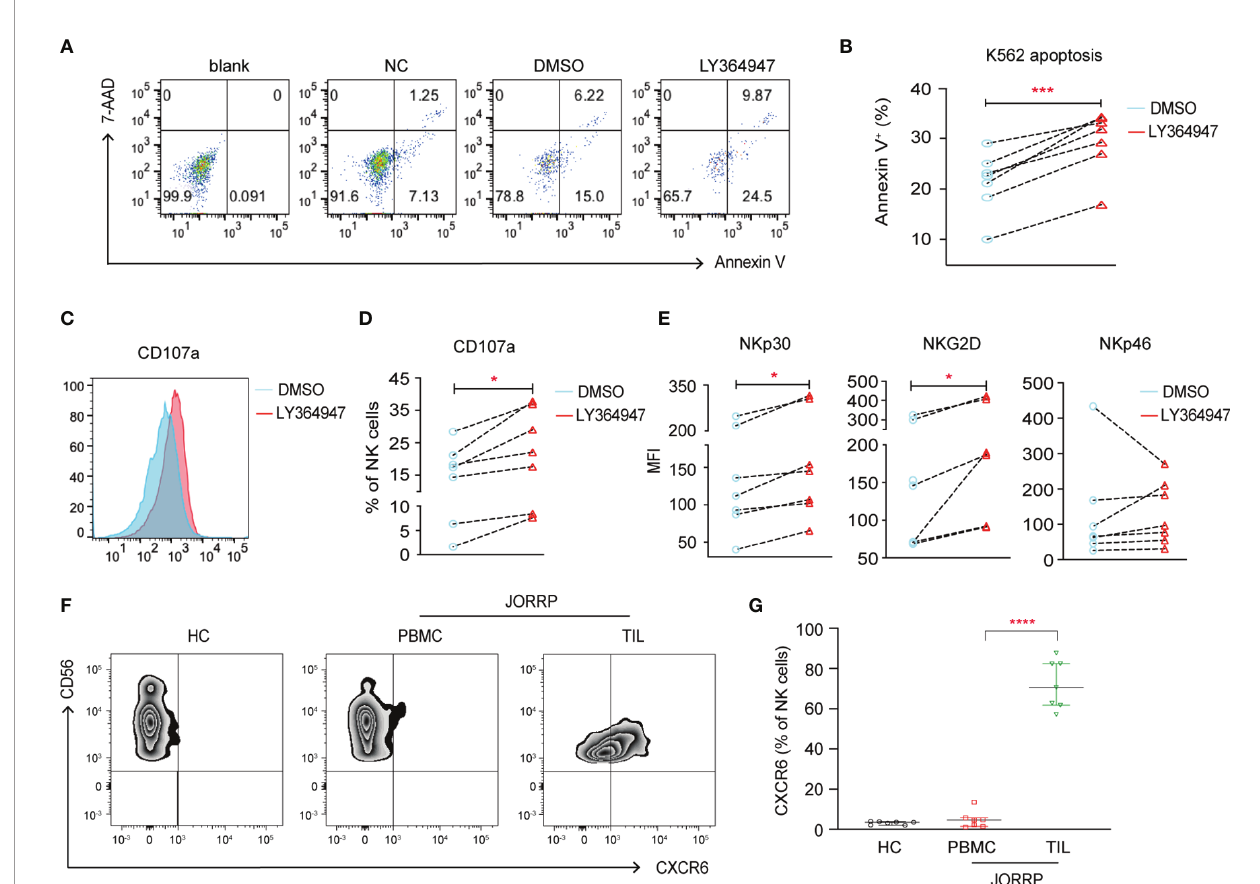
FIGURE 5 | TGF- b 1 mediates decreased NK cell cytotoxicity. (A) NK cells puri fi ed from PBMCs of JORRP patients were preincubated with LY364947 for 3 days in the presence of 100 U/ml IL-2, then stimulated with K562 target cells for an additional 6 h at the ratio = 1:1. (A, B) Representative paragraph and percentage analysis of K562 cell apoptosis (the percentage of Annexin V on K562 cells) was determined by fl ow cytometry. Blank, K562 cells alone; NC, NK cells only; DMSO, NK cells + DMSO; LY364947, NK cells + LY364947. (C, D) Representative histograms and percentage analysis of CD107a on NK cells. (E) NKp30, NKG2D, and NKp46 expression on NK cells. MFI, mean fl uorescent intensity. (F, G) PBMCs from HCs, PBMCs and TILs were isolated from JORRP patients. Representative paragraph and percentage analysis of CXCR6 gated on CD56 + CD3 - cells. TIL, tumor-in fi ltrating lymphocyte. Data are presented as median with interquartile range. Each dot represents a single individual. *P < 0.05; ***P < 0.001; ****P <